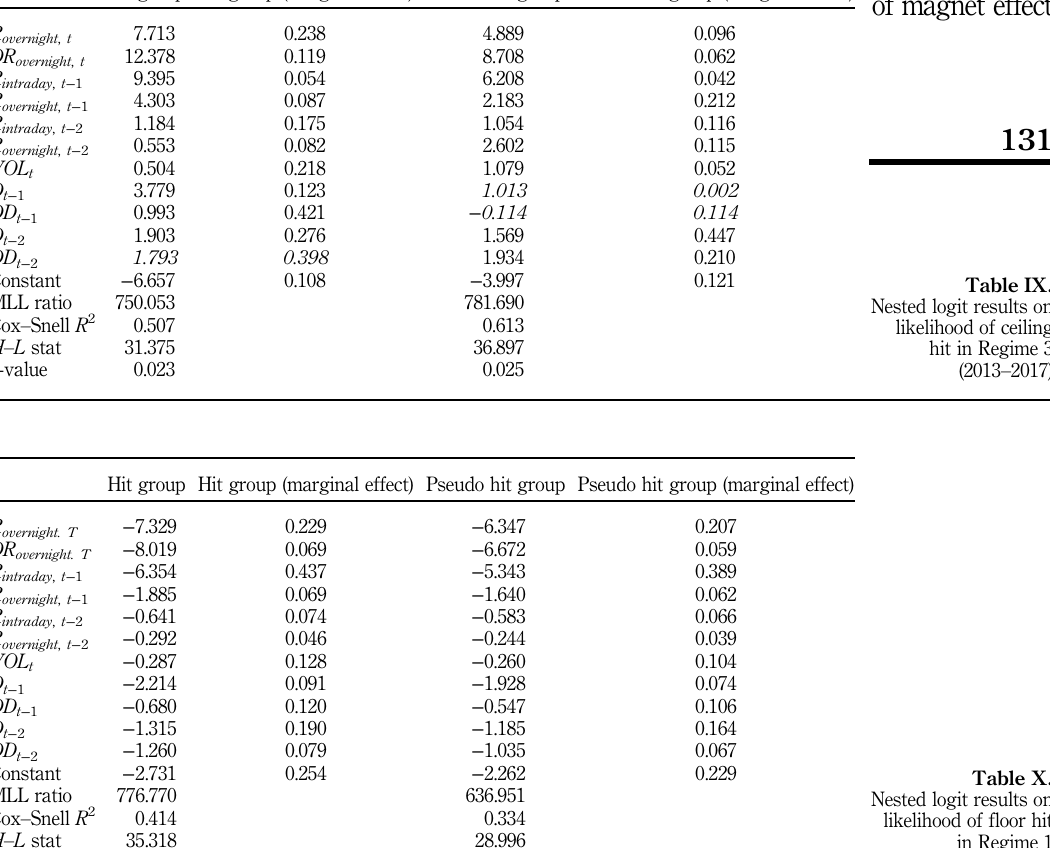
Table X. Nested logit results on likelihood of floor hit in Regime 1